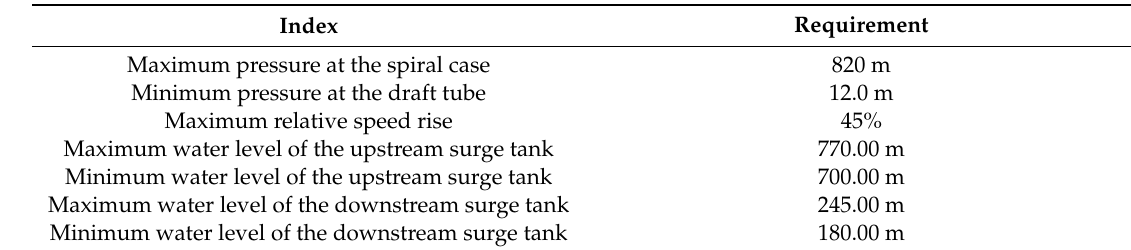
Table 2. Requirements of the